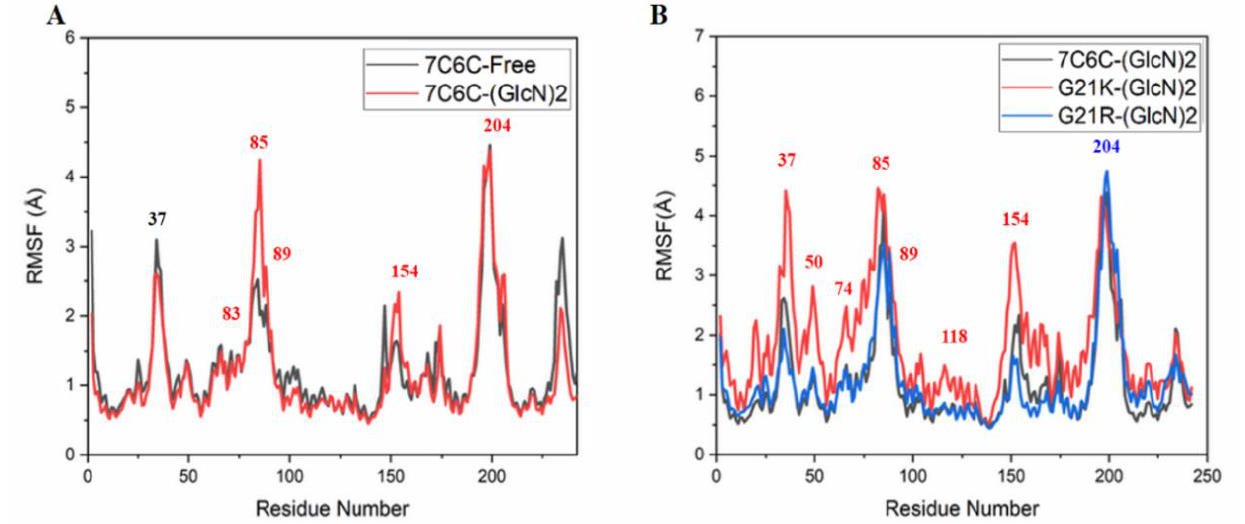
Figure 6. RMSF plots. ( A ) 7C6C-Free (black) and 7c6c-(GLCN) 2 (red); ( B ) 7c6c-(GLCN) 2 (black), G21k-(GLCN) 2 (red) and G21R-(GLCN) 2 (blue). The secondary structure change probability is shown in (Figure 7A – E).